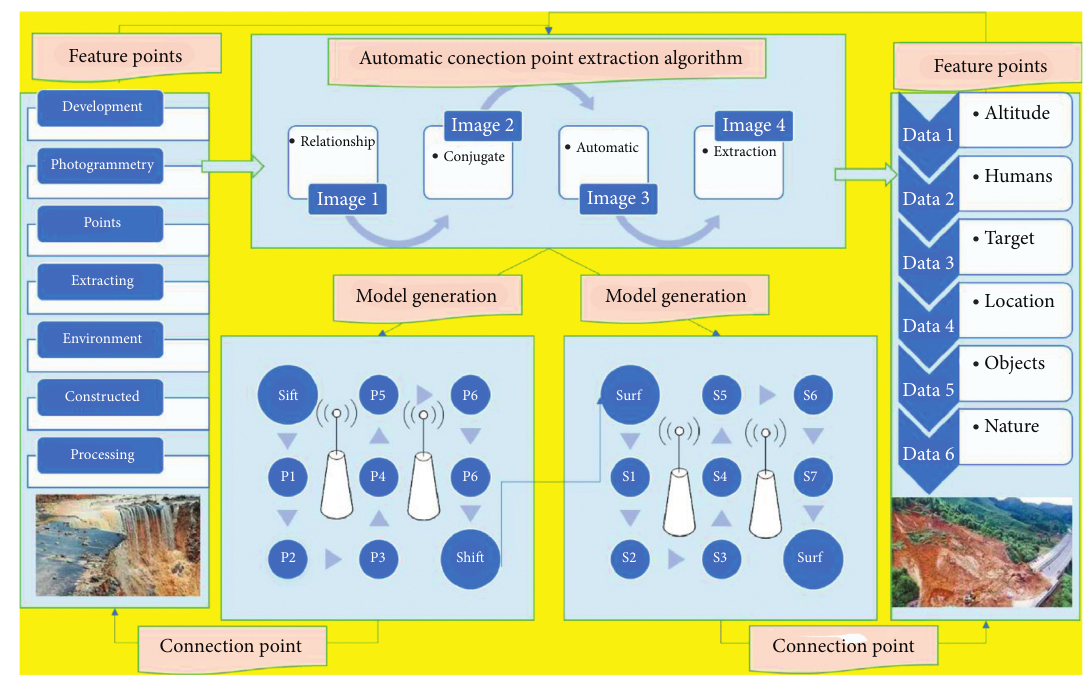
Figure 1: UAV fine inspection